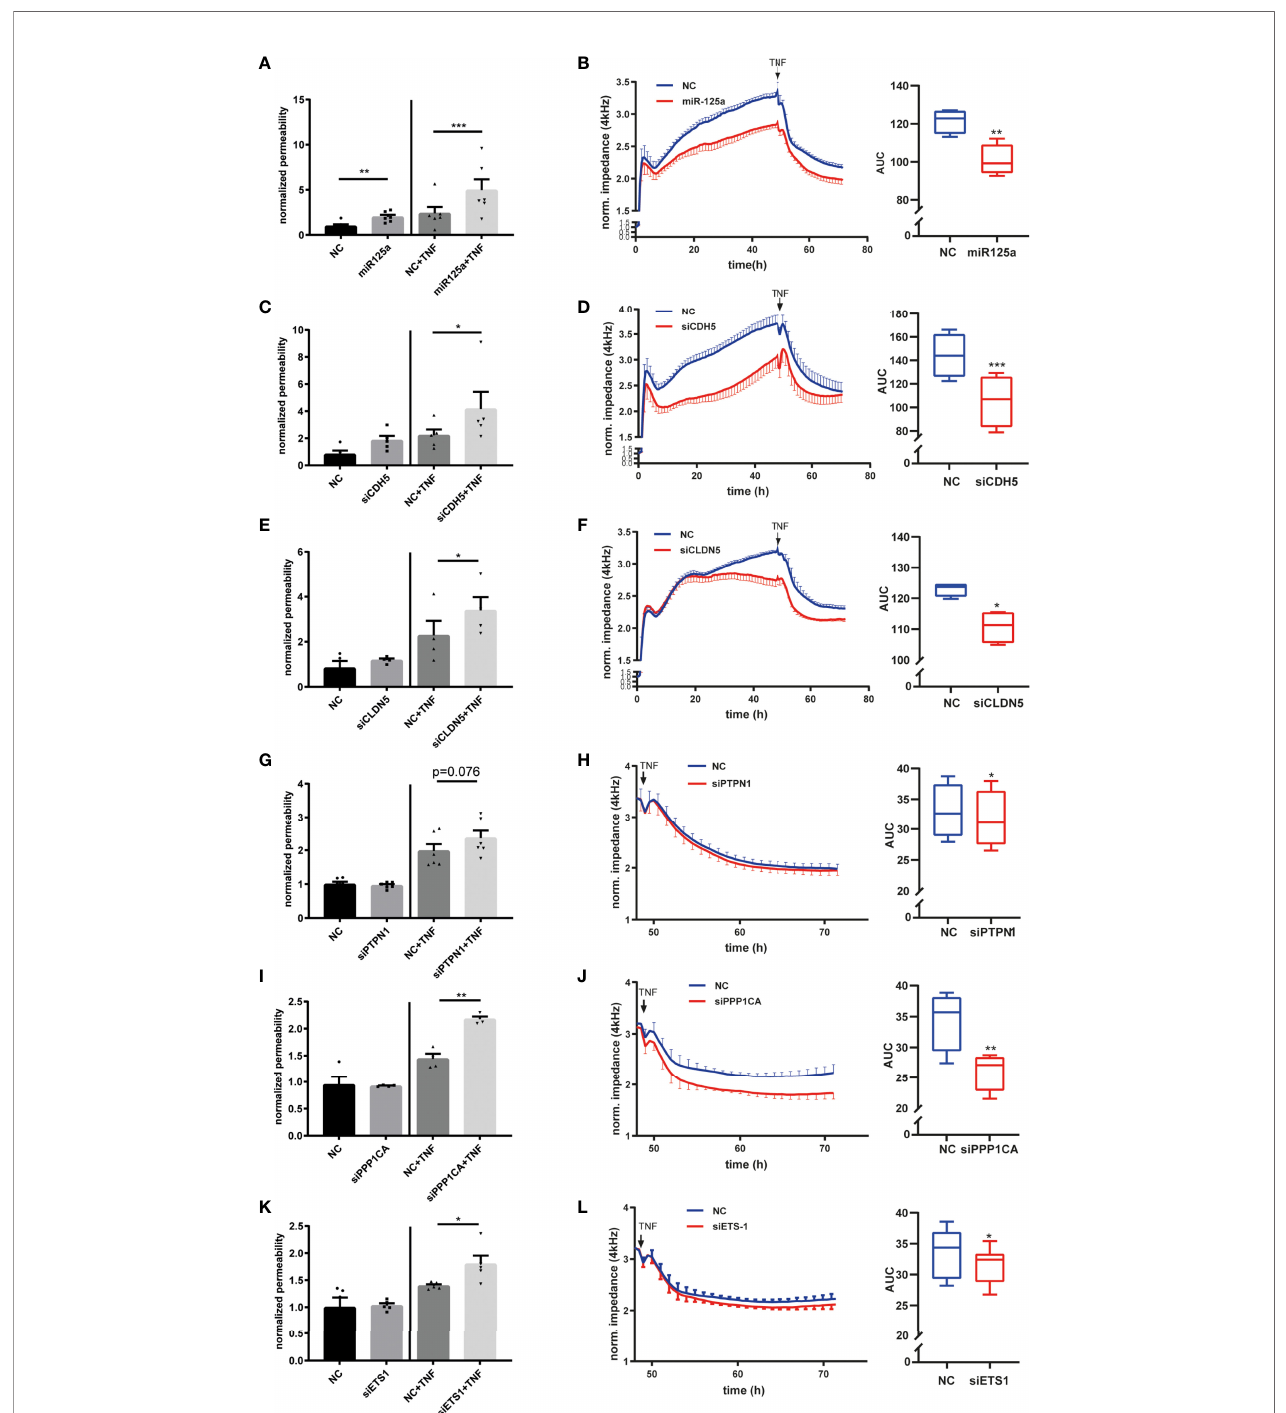
FIGURE 3 | Functional relevance of the miR – 125a-driven network on endothelial permeability. (A) Transfection of HUVEC with miR-125a increased FITC-Albumin permeability across endothelial monolayers under basal and stimulated (TNF 25ng/ml, 24 h) conditions. FITC-Albumin passage was measured 72 hours after transfection (n=6, ***p<0.001, **p<0.01, *p<0.05). (B) Compared to scrambled control (NC, blue), miR-125a (red) impaired endothelial barrier function as indicated by decreased endothelial electrical impedance in both basal and in fl ammatory conditions mimicked by TNF stimulation (n=4, **p<0.01). (C – L) Individual knock-down of each of the functional network members by speci fi c siRNA interference targeting the indicated gene. (C, E, G, I, K) Measurement of FITS-BSA-Passage in basal and TNF-stimulated conditions (D, F, H, J, L) Measurement of electrical impedance, basal and after TNF stimulation (n=4-6, ***p<0.001, **p<0.01,